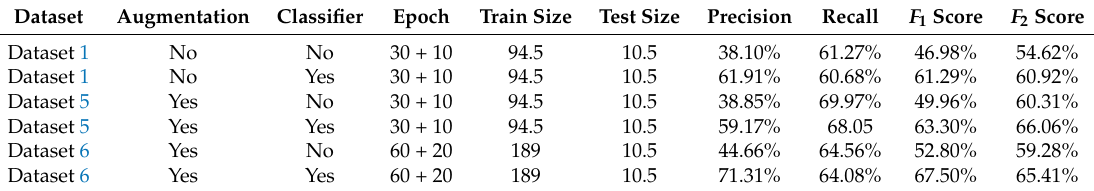
Table 7. The results of the effect of the pre-classifier